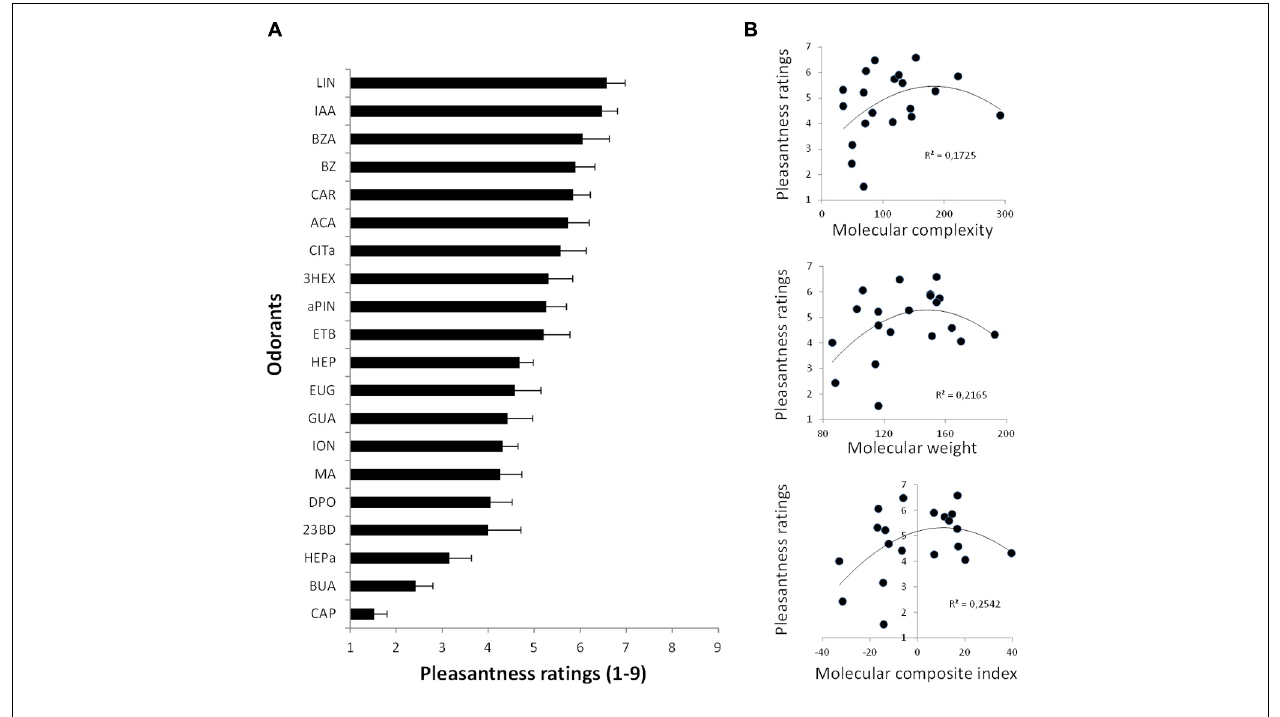
see also Kermen etal., 2011 for details), of molecular weight and of physicochemical properties (molecular composite index based on a principal component analysis with physicochemical data obtained from Dragon ®